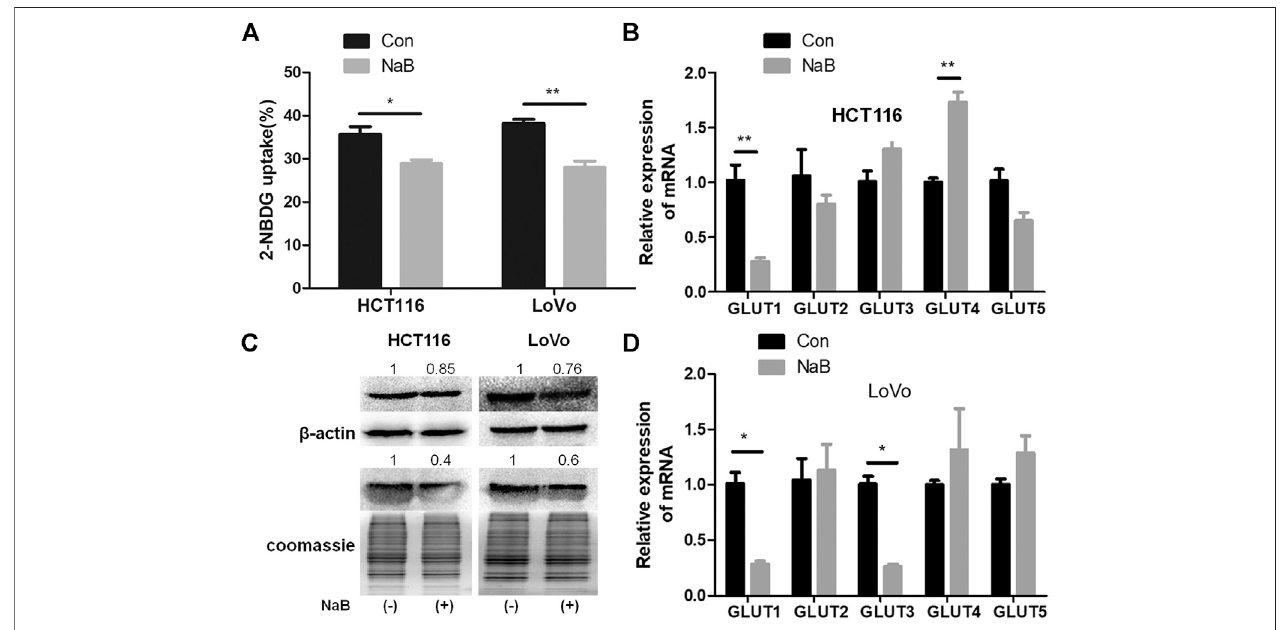
FIGURE 1 | Butyrate inhibited glucose uptake and the membrane abundance of GLUT1 in colorectal cancer cells. (A) The glucose uptake ef fi ciencies of HCT116 and LoVocellsbeingtreatedwith2 mMbutyrate (annotated as “ NaB ” )orPBSvehicle(markedas “ Con ” )for24 hweremeasured,usinga fl uorescentglucoseanalogue, 2-NBDG. (B) ThemRNAlevelsofGLUT1-5inHCT116cellsafterincubatingwith2 mMbutyrateorPBSfor24 hweretestedusingquantitativePCR(qPCR). (C) Thetotal protein level of GLUT1 (labeled as “ GLUT1 t ” ) and GLUT1 abundance in the membrane fraction (labeled as “ GLUT1 m ” ) in HCT116 and LoVo cells w/o butyrate treatment was measured using western blotting. Cell membrane proteins were extracted from both cell lines after addition of 2 mM butyrate or PBS for 24 h, and the abundance of membrane GLUT1 was measured by western blotting. Coomassie bright blue staining of polyacrylamide gels containing cell membrane proteins representedtheconcentrationofcellmembraneproteins. (D) ThemRNAlevelsofGLUT1-5weretestedusingqPCRinLoVocellsbeingincubatedwith2 mMbutyrateor PBS for 24 h. The error bars showed standard deviations from independent triplicates. * p < 0.05, ** p < 0.01.